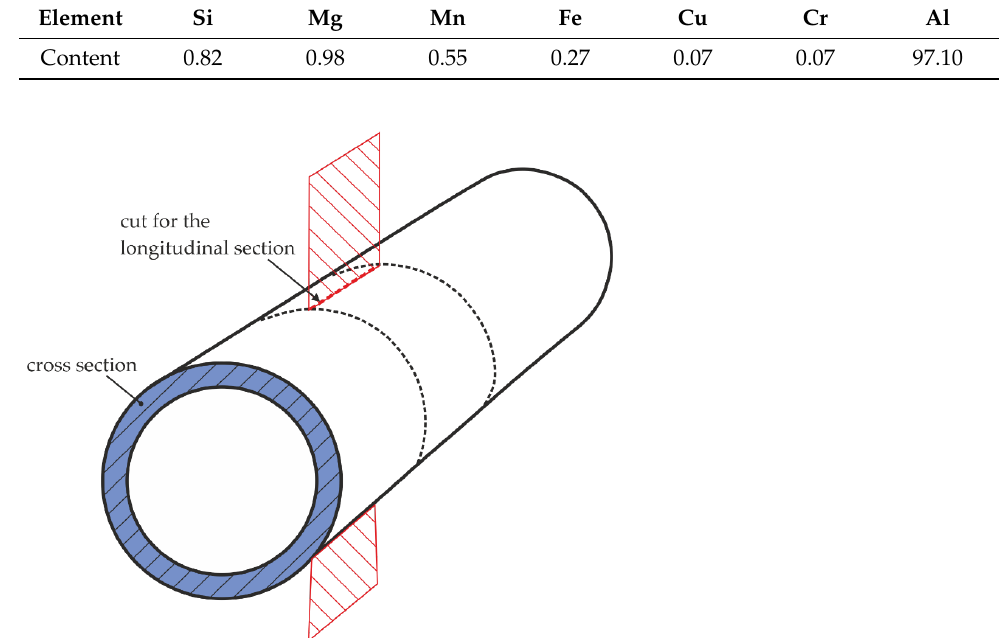
Figure 2. Schematic of the arrangement of the cross sections and longitudinal sections on the ex- trusion profile. extrusion